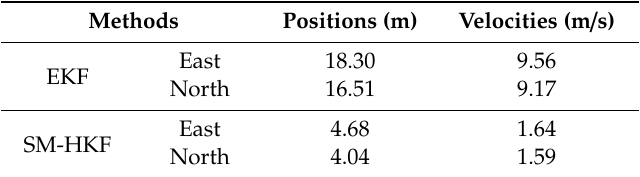
Table 2. The means of the RMSEs of estimation errors obtained by EKF and SM-HKF during the time segment with unknown but bounded (UBB)